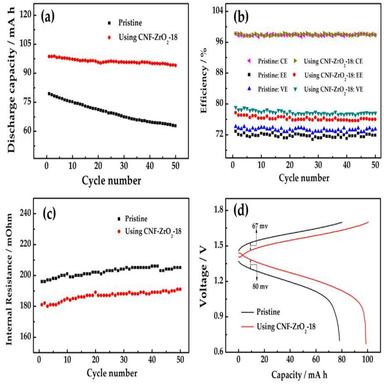
Discharge capacity (a), efficiency (b), internal resistance (c) and charge-discharge curves (d) of cells without and with CNFeZrO2-18 for 50 cycles at 80 mA cm2 .